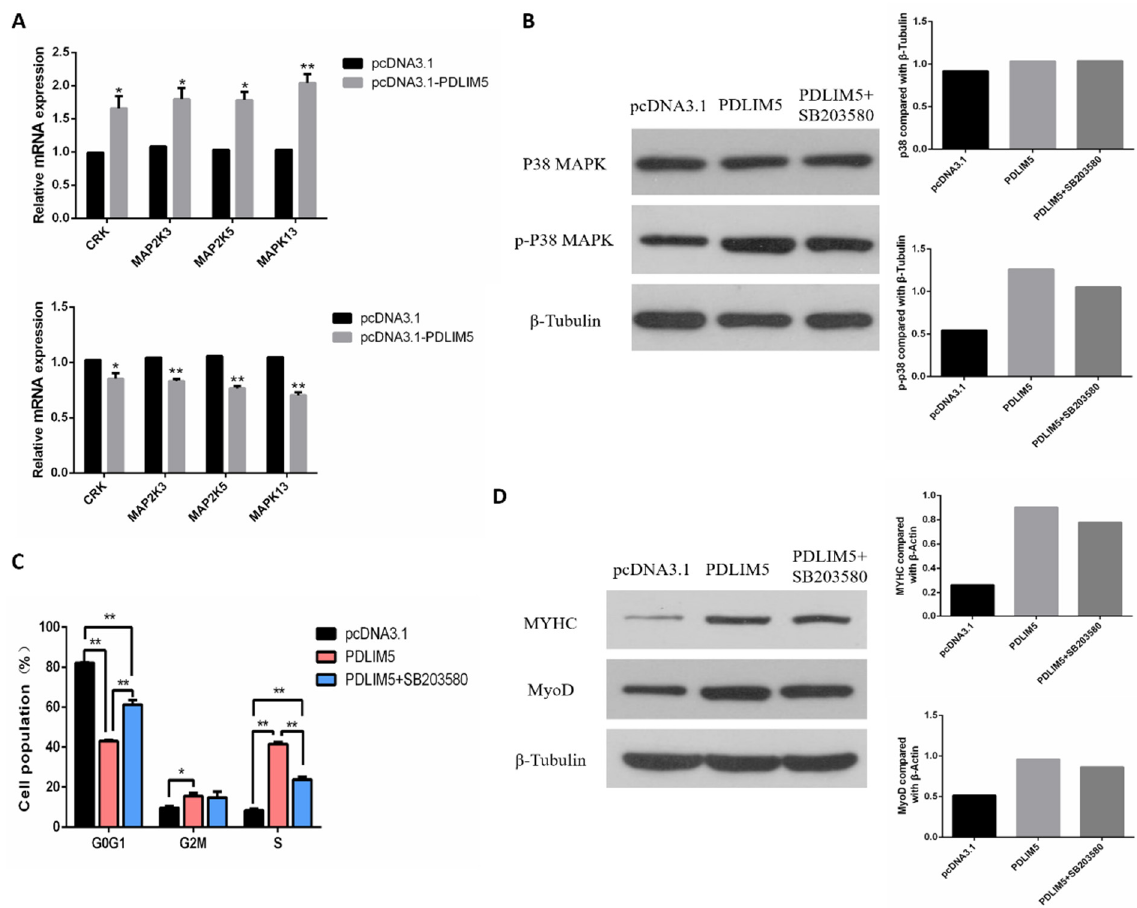
Figure 5. PDLIM5 regulated muscle development through the p38-MAPK pathway. ( A ) mRNA expression of MAPK pathway related genes transfected with si-PDLIM5 or pcDNA3.1-PDLIM5. ( B ) After overexpressing PDLIM5 in SMSCs and adding exogenous PDLIM5 and SB203580, the protein abundance of p38 and p -p38 was measured by Western blotting. In SMSCs with and without SB203580, the effect of PDLIM5 on cell proliferation ( C ) and differentiation ( D ) was determined. * p < 0.05; ** p < 0.01 vs. NC and pcDNA3.1 (negative control) ( n = 9).